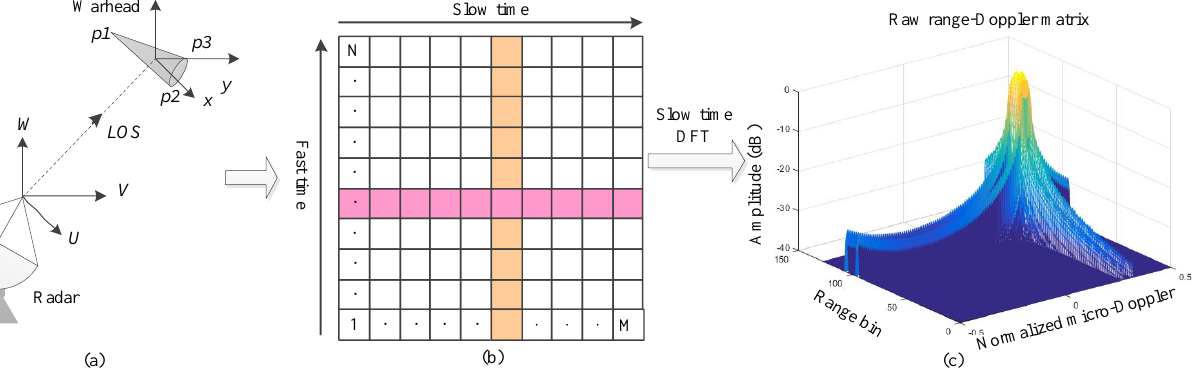
Figure 1. Geometric model and signal model: ( a ) target model; ( b ) series of M chirps. The baseband signal corresponding to each chirp is digitized and generated N samples. It is arranged in a matrix of N × M elements; ( c ) the generated range-Doppler